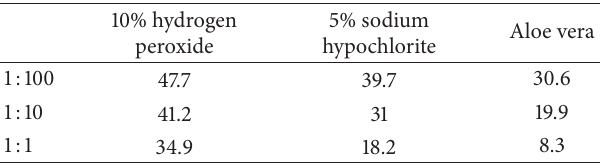
Table 3: Comparison of three disinfectants at various concentra- tions